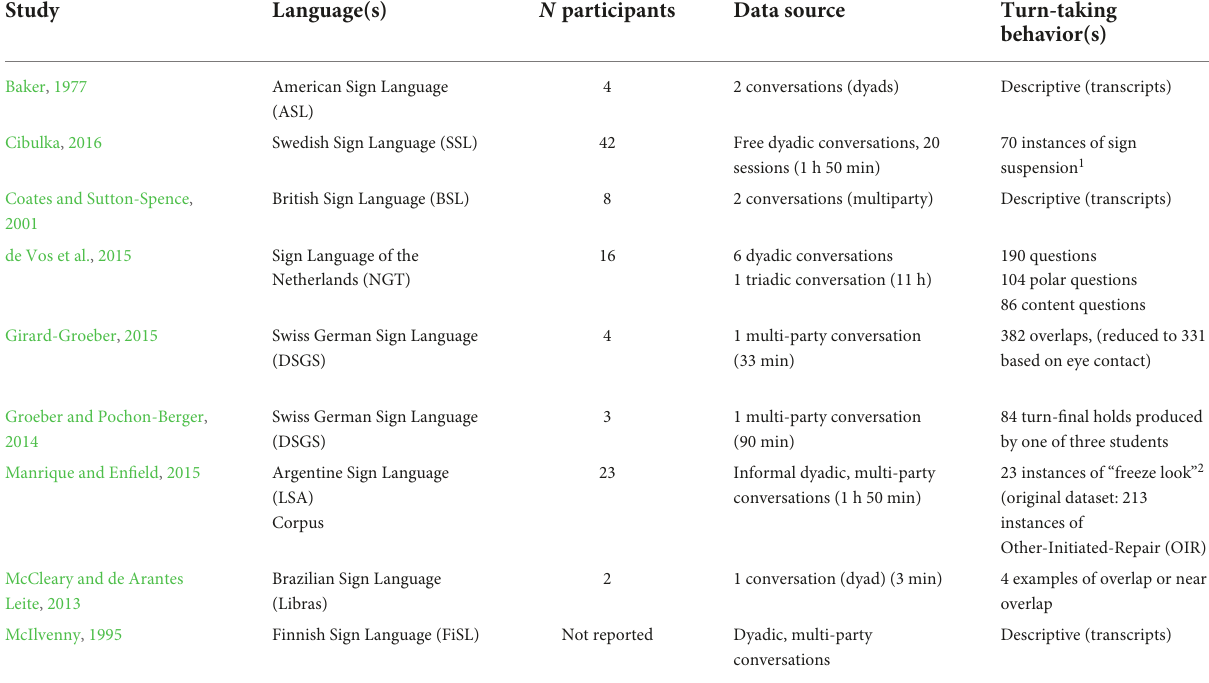
TABLE 1 Studies of turn-taking in national sign languages.